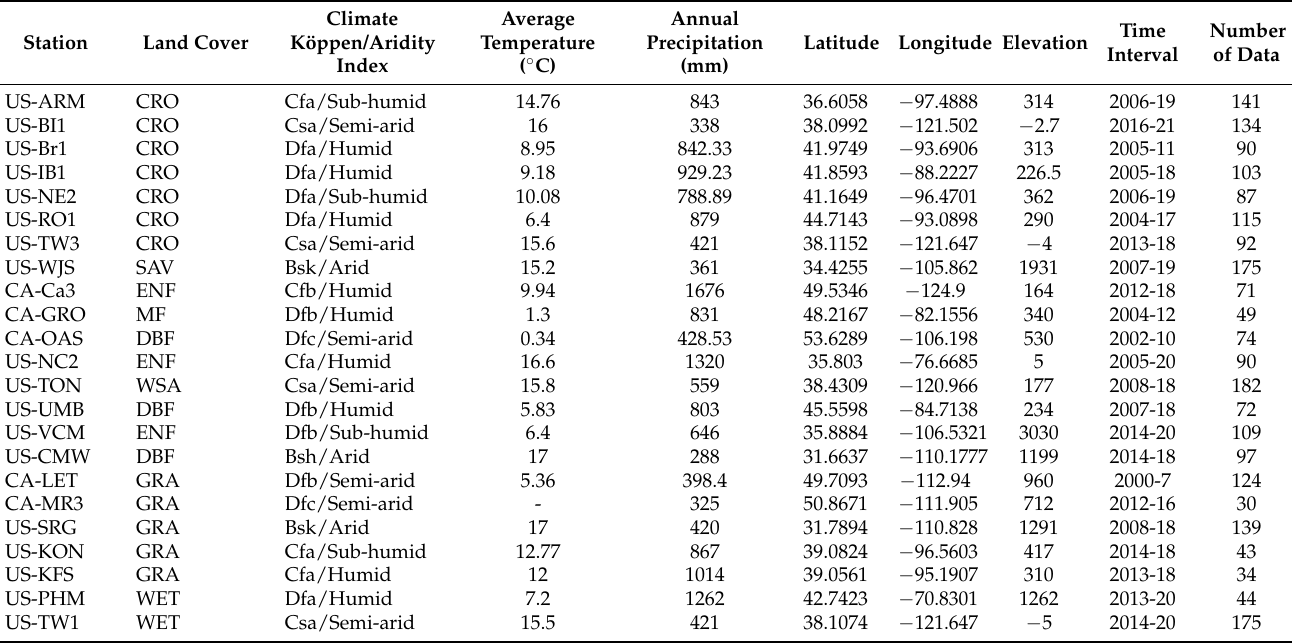
Table 1. Data of study